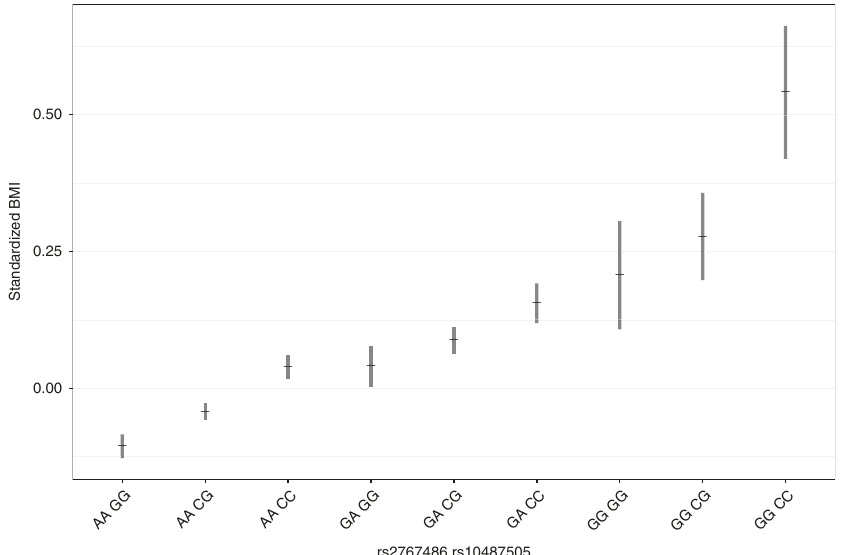
Fig. 6 BMI at 1.5 years strati fi ed by combined genotype of rs2767486 ( LEPR ) and rs10487505 ( LEP ). The plot shows the mean standardized BMI of all samples (discovery + replication) at 1.5 year strati fi ed by the genotype combination of the top hits in LEPR (rs2767486) and LEP (rs10487505). Error bars represent one SEM on each side of the